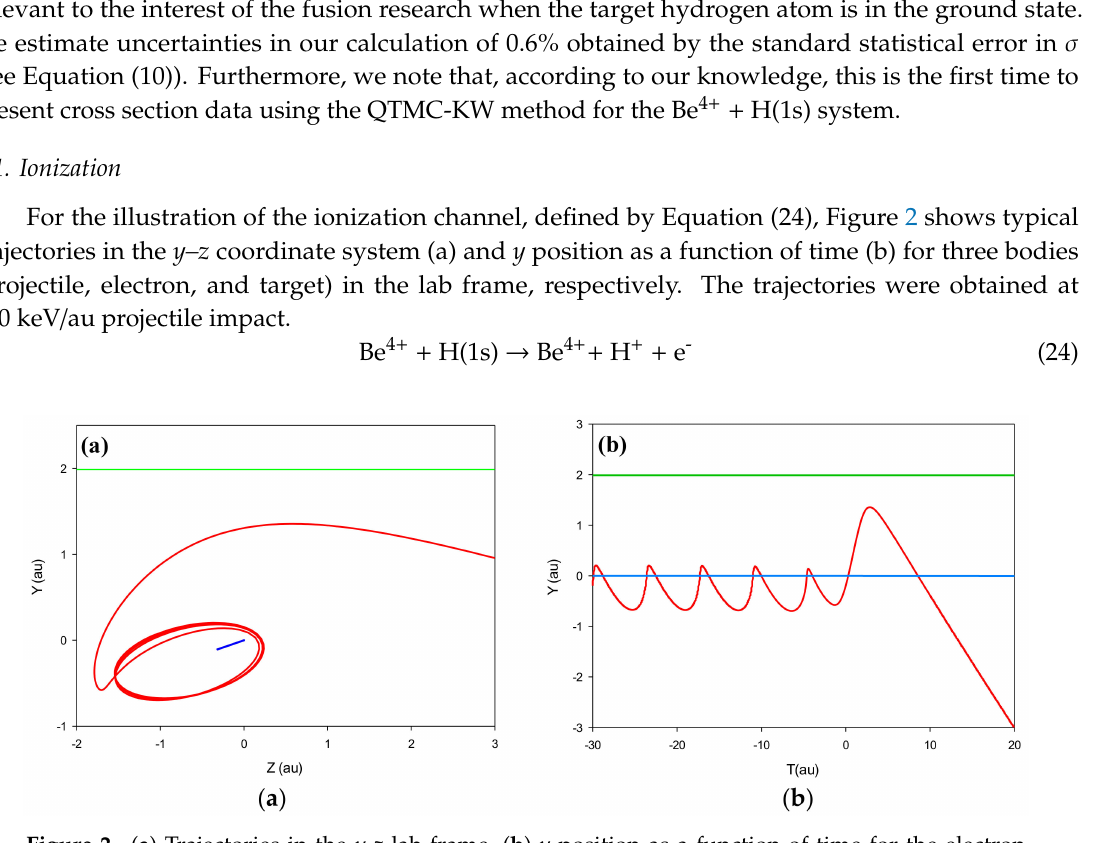
Figure 2. ( a ) Trajectories in the y-z lab frame, ( b ) y position as a function of time for the electron (red line), projectile (green line) and target (blue line) for ionization channel and for Be 4 + with E = 900 keV /